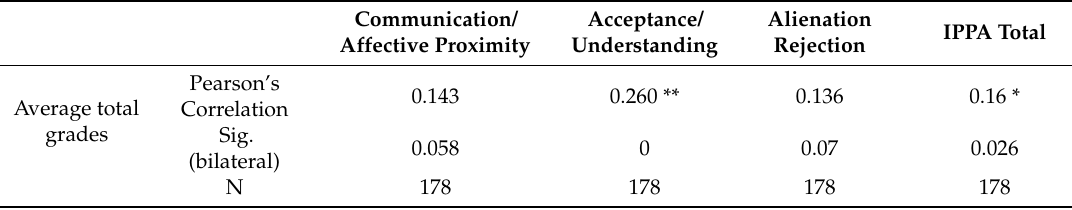
Table 8. Correlation between the student–teacher relations subscale with the average of the total grades, in RE.